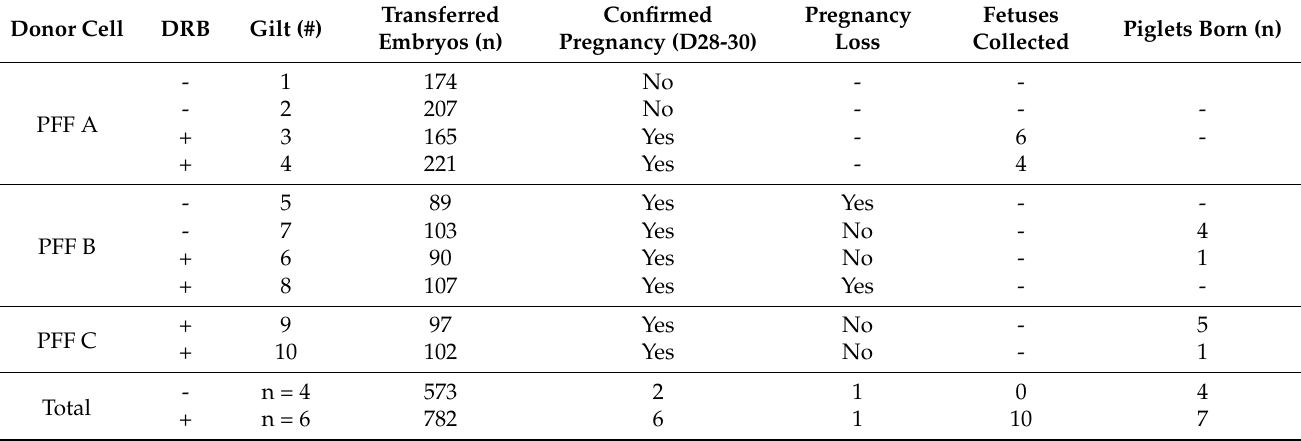
Table 1. Post-implantation development of SCNT embryos produced using three different cell lines and treated with Scriptaid or Scriptaid + DRB for 15 h and transferred to recipient